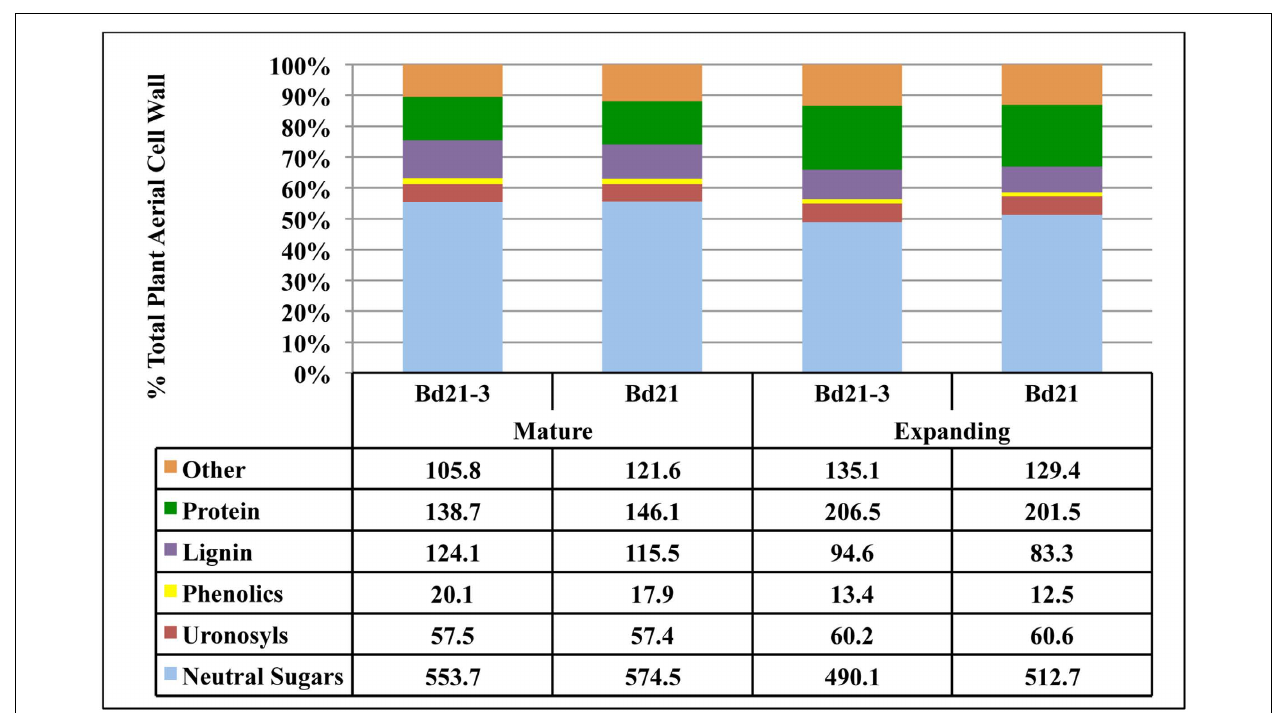
FIGURE 5 | Determination of total aerial plant cell wall composition for Brachypodium distachyon. Using total tissue harvest yields, tissue cell wall yields and tissue compositional analysis, values were calculated to determine